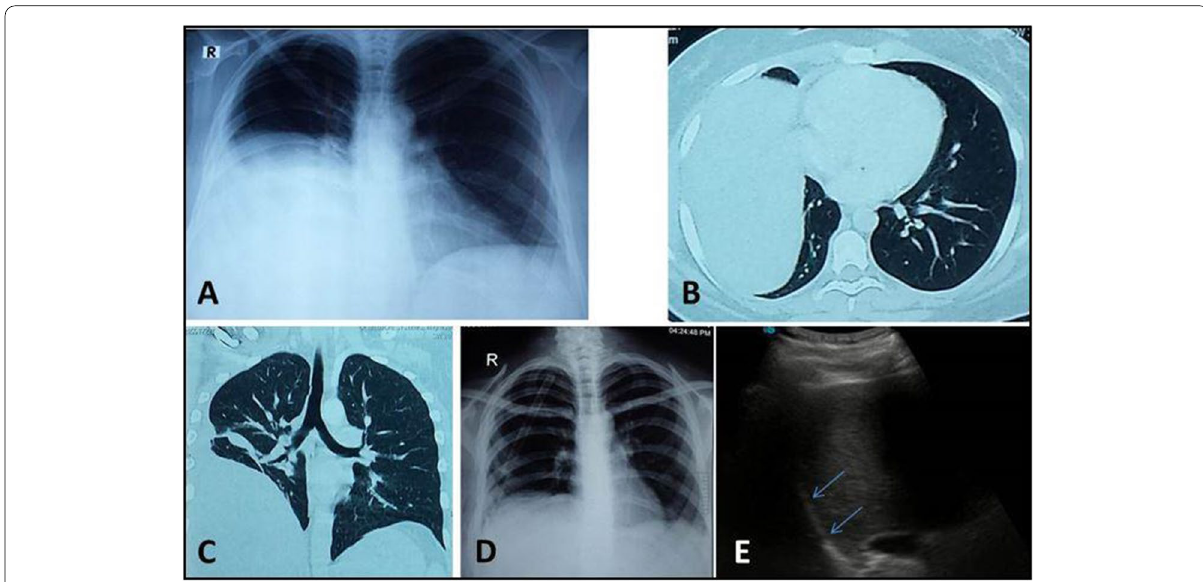
Fig. 3 Female patient 22 years old with right diaphragmatic paralysis: A Pre‑operative CXR showing significant right diaphragmatic paralysis. B , C CT chest images showing the liver at the site of the paralysis. D Post‑operative CXR with an intercostal tube. E Post‑operative DUS image showing the right diaphragm (arrows)